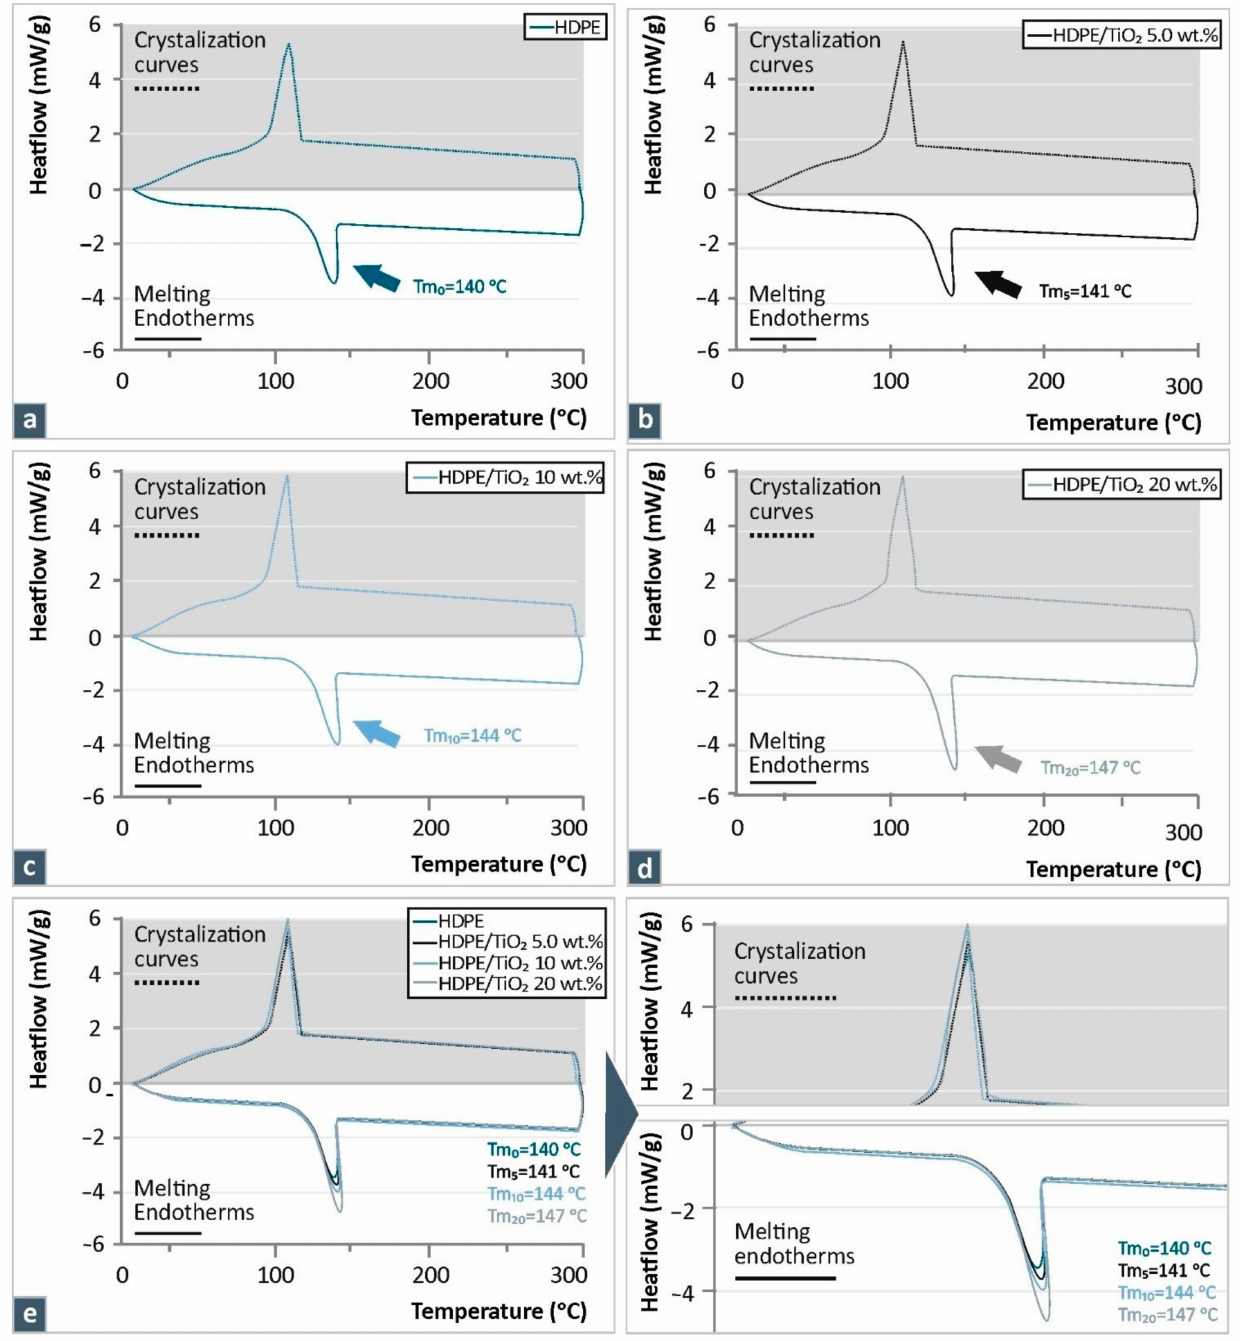
Figure 6. Overall DSC data for HDPE with TiO 2 filler at ( a ) 0, ( b ) 5, ( c ) 10, and ( d ) 20 wt.%; ( e ) DSC comparative data for HDPE with TiO 2 fillers all